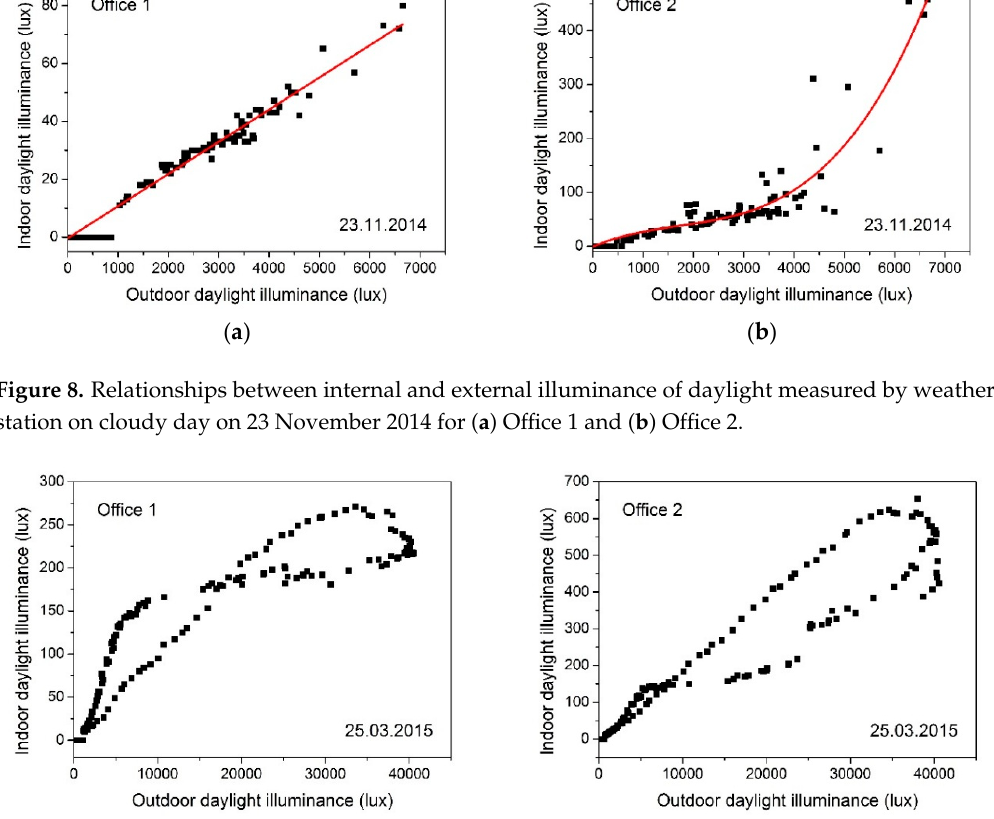
Figure 9. Relationships between internal and external illuminance of daylight measured by the weather station on a sunny day (25 March 2015) for ( a ) Office 1 and ( b ) Office 2.